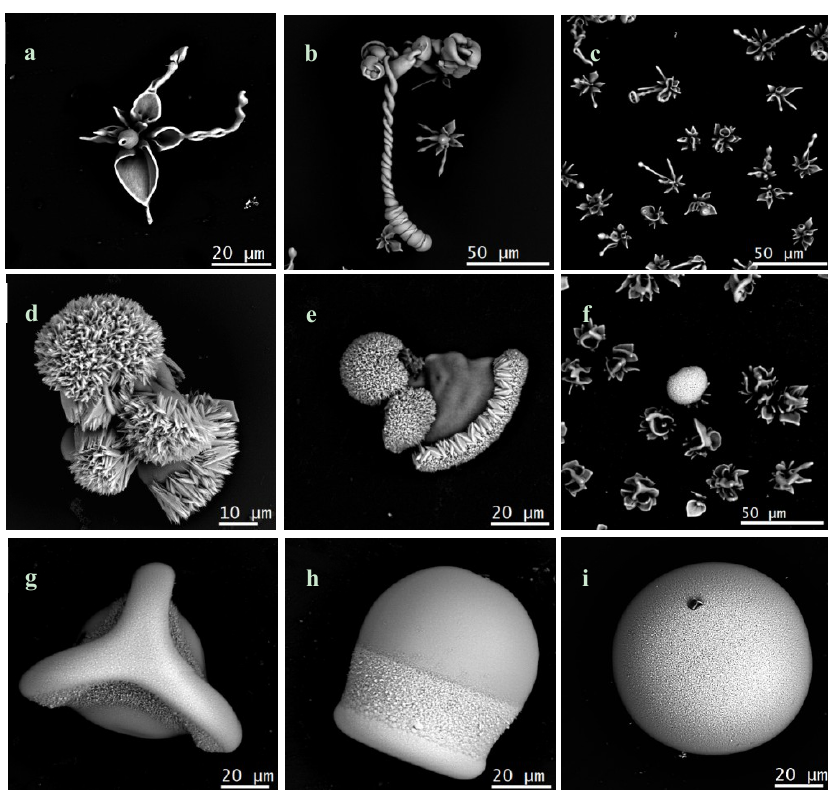
Figure 5. Flower-like and helical morphologies in samples without PA added ( a–c ). Spherulitic, sheets and flower-like morphologies observed when PA is not in direct contact with reactions solutions ( d–f ). Semispherical and spherical morphologies observed when solutions are mixed with PA ( g–i ). In all cases the samples were exposed to UV radiation during 24 h. Crystals 2019 , 9 , x FOR PEER REVIEW